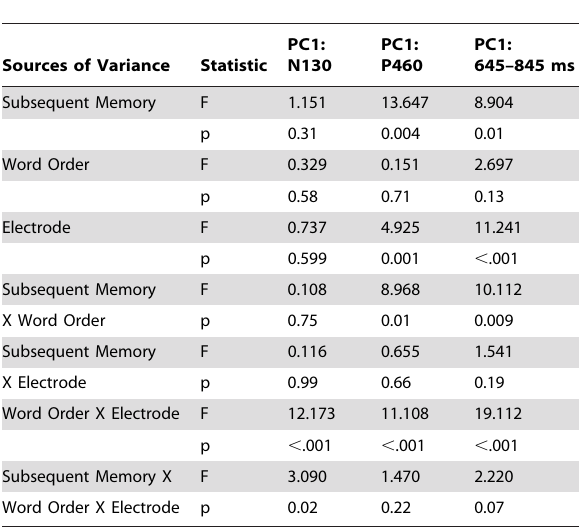
Table 1. Results of the repeated measures ANOVAs for the first principal component